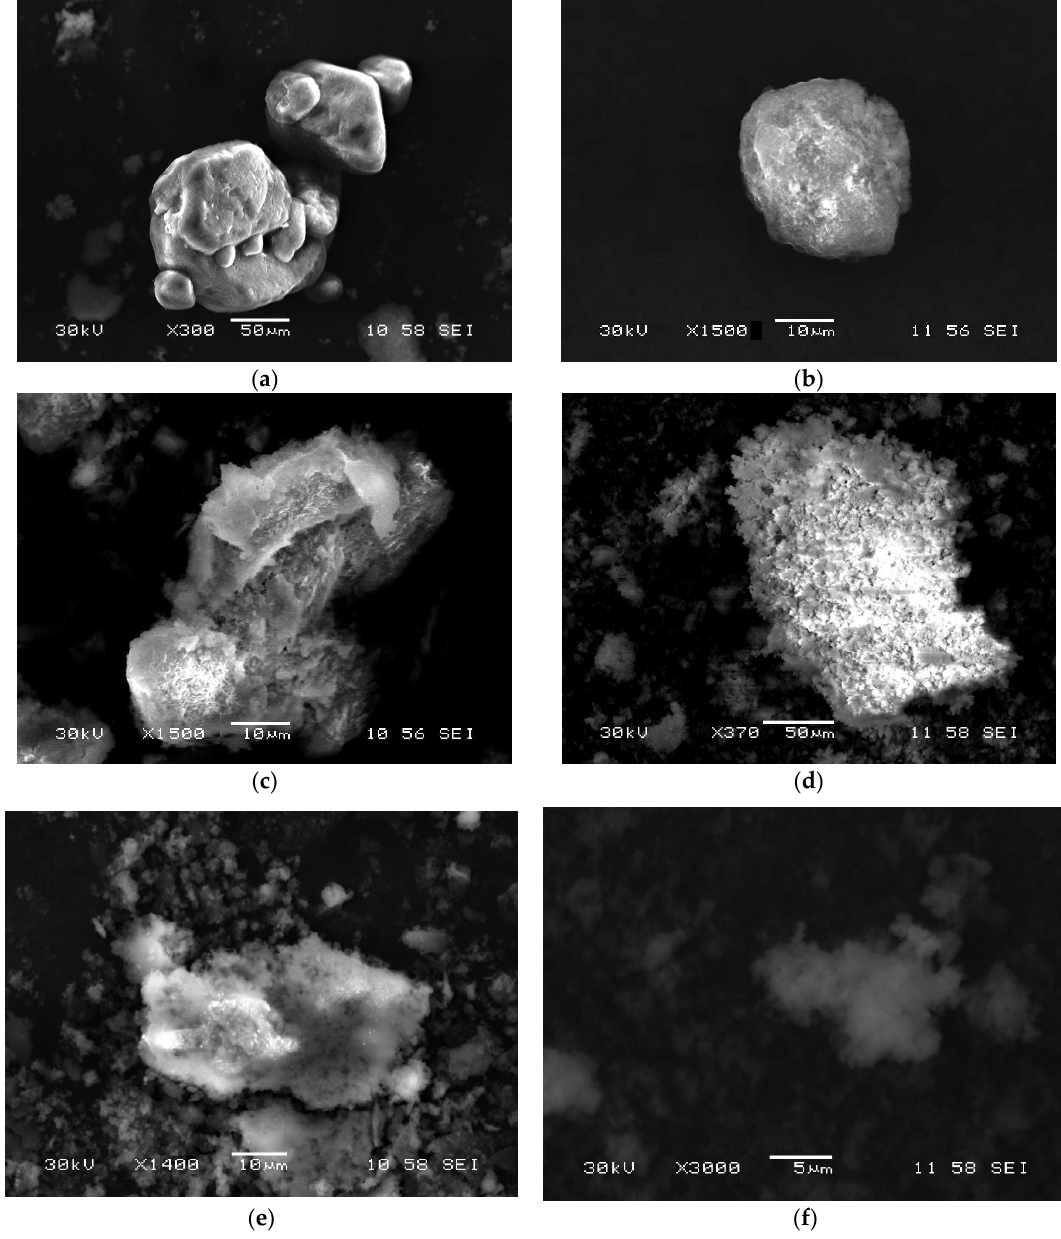
Figure 2. Morphological analysis with secondary electrons of the suspended particulate matter. Coarse particle dimensions: ( a ) 130 × 150 µm, ( b ) 30 × 35 µm, and ( c ) 50 × 60 µm. Fine particles dimensions: ( d ) 160 × 227 µm, ( e ) 51 × 84 µm, and ( f ) 13 × 17 µm.